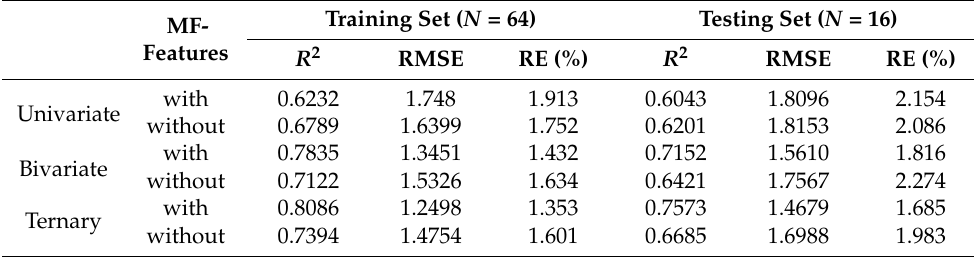
Table 6. The influence of MF parameters on model accuracy.